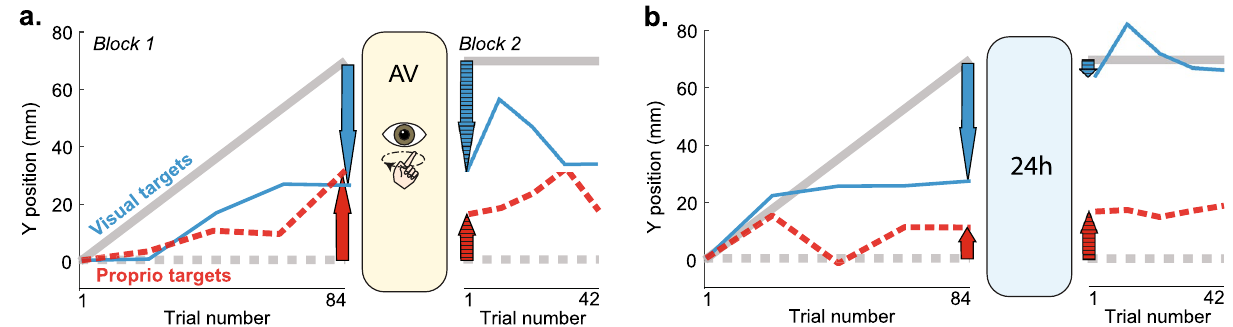
Figure 2. Example participants’ y-dimension indicator finger endpoints on P and V targets, averaged every 4 trials for clarity (red and blue lines). ( A ) This Active/Vision group participant recalibrated both vision and proprioception robustly during Block 1 (solid arrows). After active circle tracing with the visible target hand, the participant continued to undershoot V targets in Block 2, suggesting full visual retention. However, overshooting of P targets was reduced, which could indicate proprioceptive forgetting. ( B ) This participant in the 24H group lost most of their visual recalibration after 24 h (crosshatched blue arrow compared to solid blue arrow), but fully retained their overshoot of proprioceptive targets. X-axis values indicate total number of individual trials elapsed, including P, V, and VP, but only P and V data is plotted for